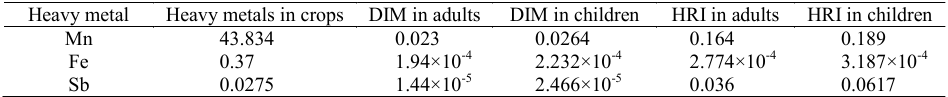
Table 7: DIM and HRI of heavy metals in adults and children Heavy metal